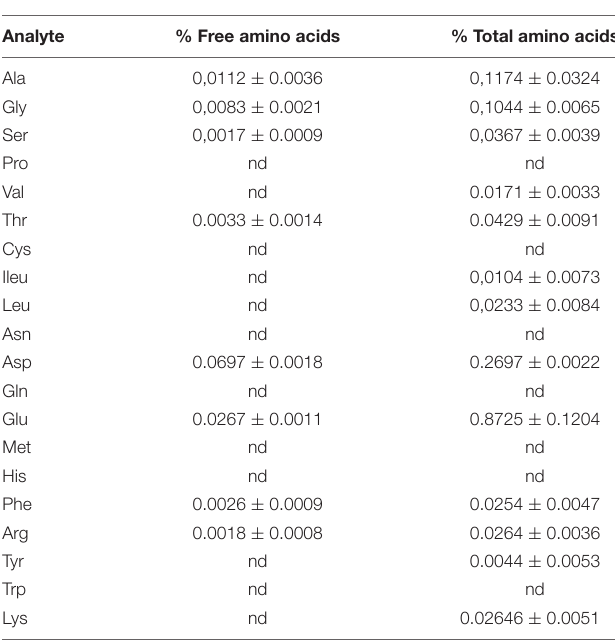
TABLE 3 | Free and total amino acids quantified in